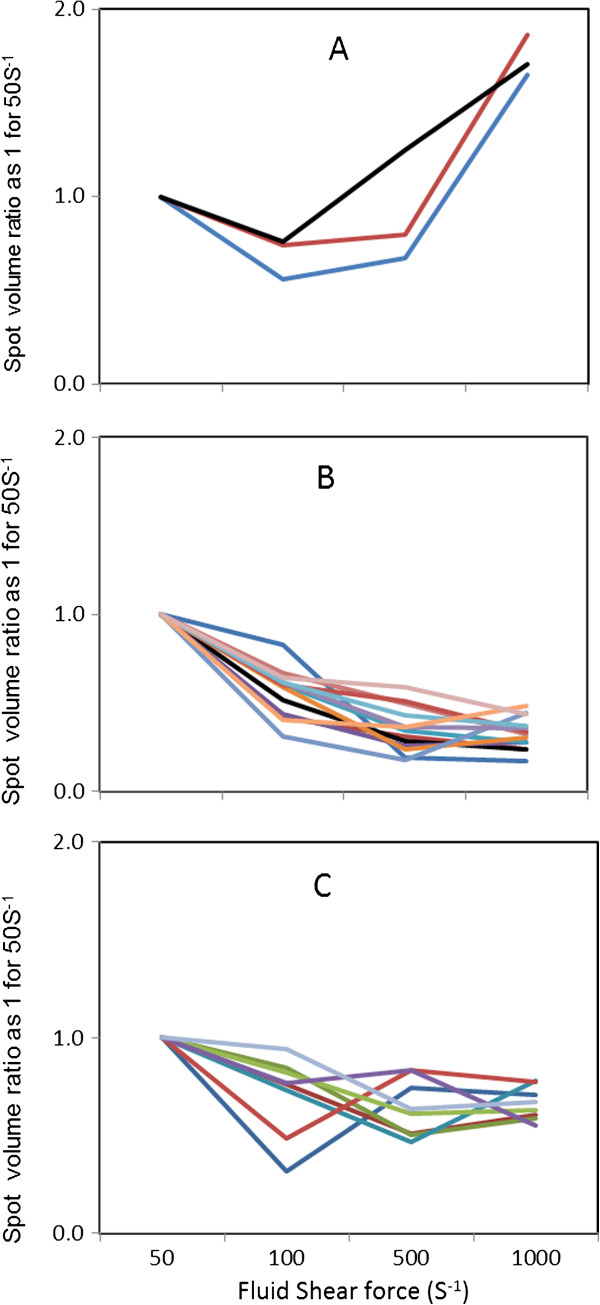
Protein expression as a function of fluid shear forces. Number shown in the bracket below corresponds to Spot ID in Figure 3. A: membrane fraction (20, 33, 42); B: membrane fraction (2, 3, 4, 7, 8, 14, 15, 17, 21, 25, 27, 34, 37); C: Cytosolic fraction (1, 7, 12, 14, 19, 20, 26, 33).